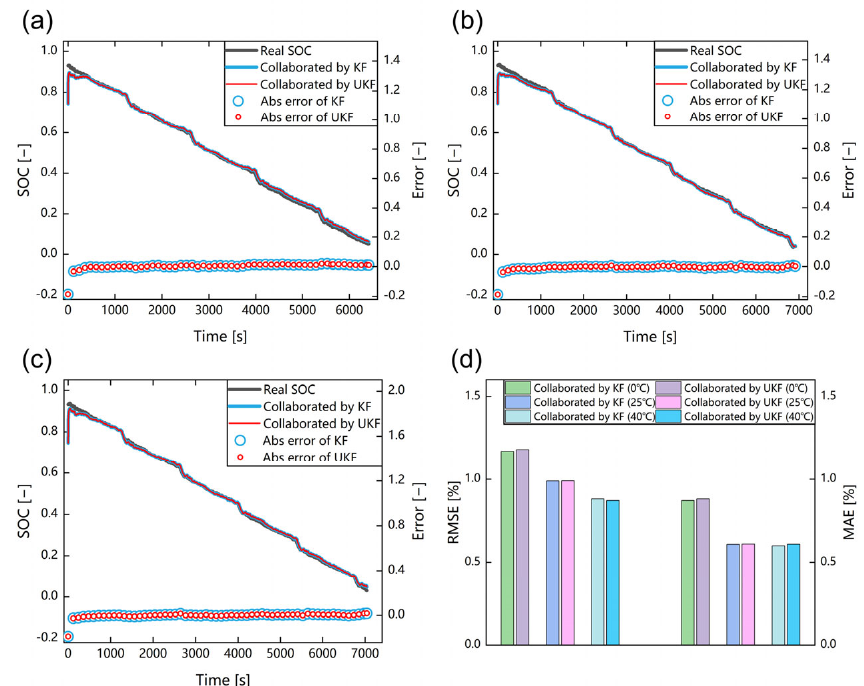
Figure 7. SOC estimation results with end-cloud collaboration system for FUDS driving cycle under different temperatures with an incorrect initial value of 80%. ( a ) Estimation result under 0 ◦ C. ( b ) Estimation result under 25 ◦ C. ( c ) Estimation result under 40 ◦ C. ( d ) RMSE and MAE analysis for all estimation results.